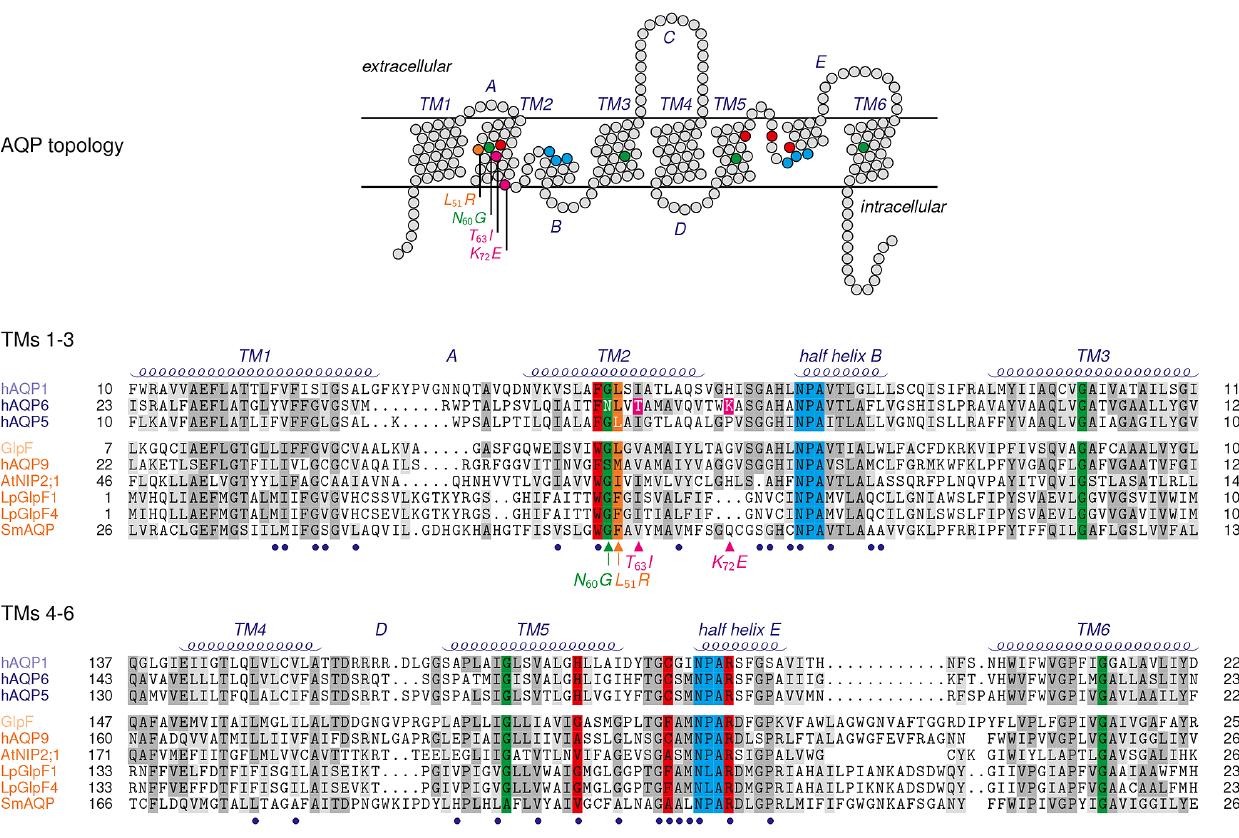
FIGURE 2 |Topology and sequence comparison of selected AQPs. Red shading highlights residues of the ar/R selectivity filter, blue the NPA regions. Glycines of helix contact points are colored in green, and the Leu51Arg mutation site in AQP5 in orange. The Thr63Ile and Lys72Glu mutations of AQP6 are colored magenta. Connecting loops are labeled A–E, and the transmembrane spanning helices TM1-6. The termini and